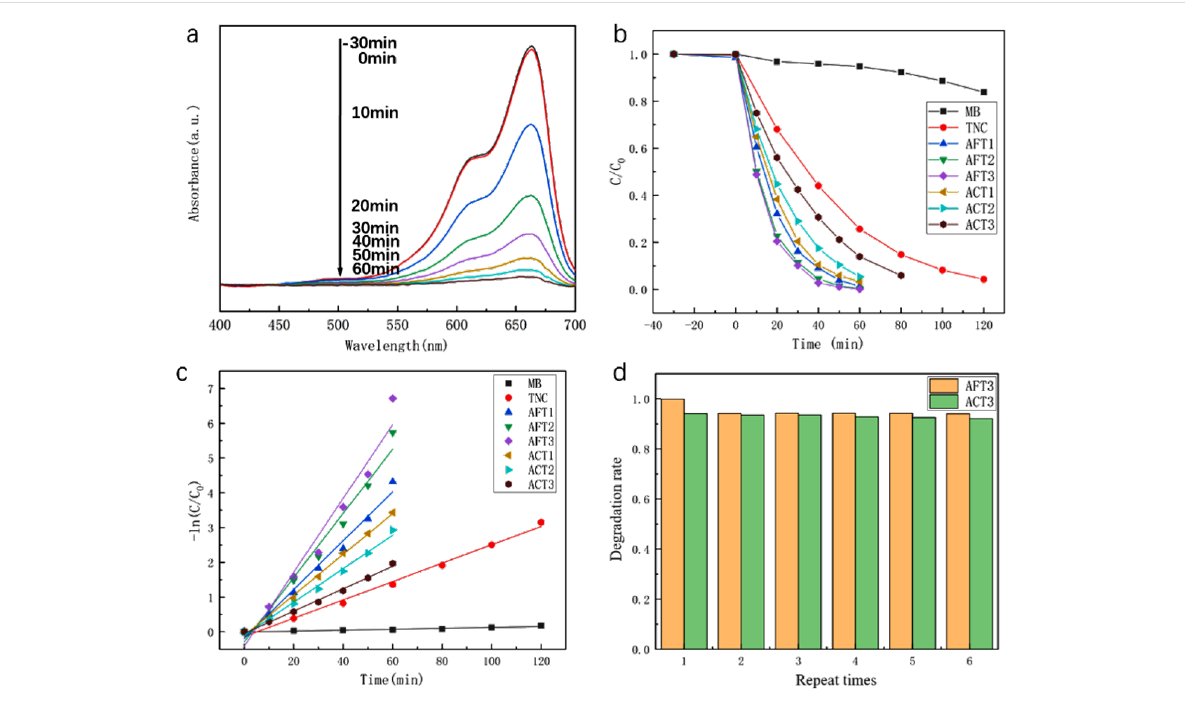
Figure 7: Photocatalytic activity for the degradation of MB: (a) UV–vis absorption spectra for the photocatalytic degradation of MB in the presence of AFT1 sample, (b) photocatalytic degradation rate of MB by different samples and pure MB under UV–vis light, (c) kinetics of different samples, (d) recycling of AFT3 and